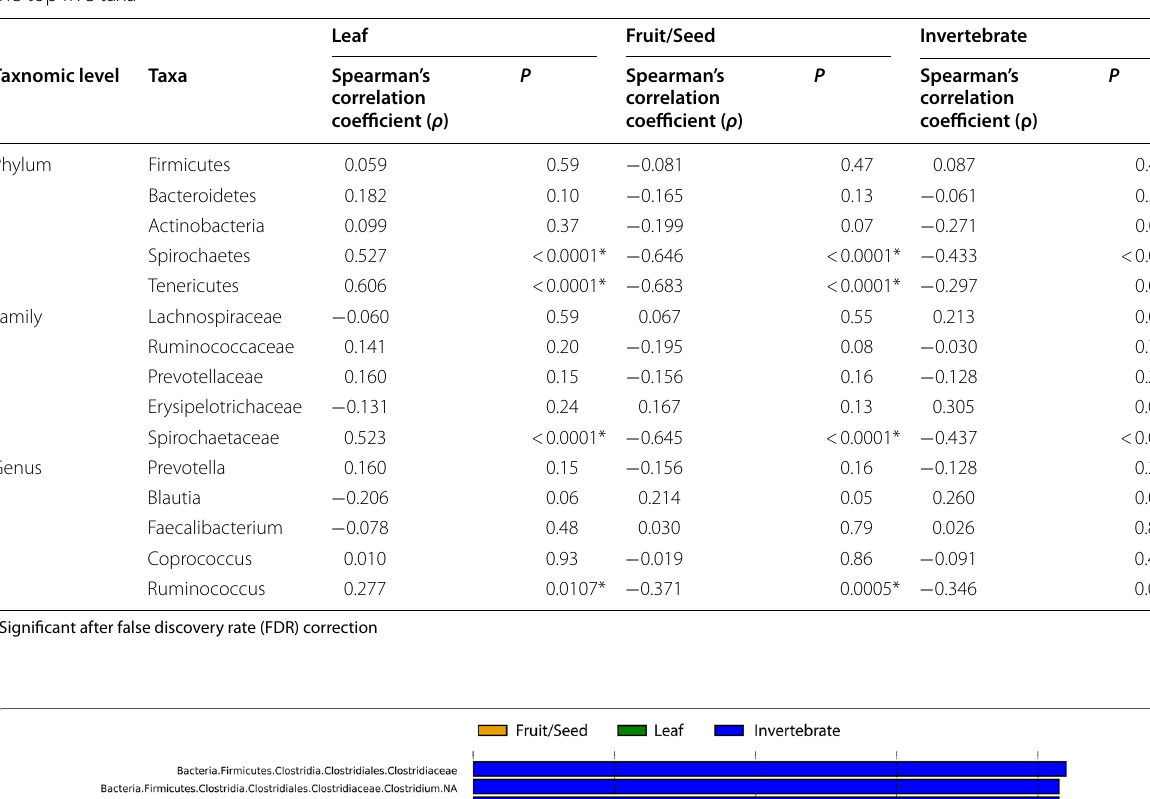
Table 3 Summary of the Spearman’s rank correlations between proportion of food intake of the three major foods and abundance of the top five taxa